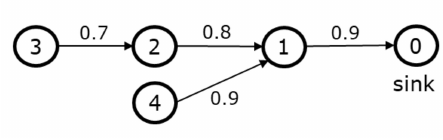
Figure 1. An example network